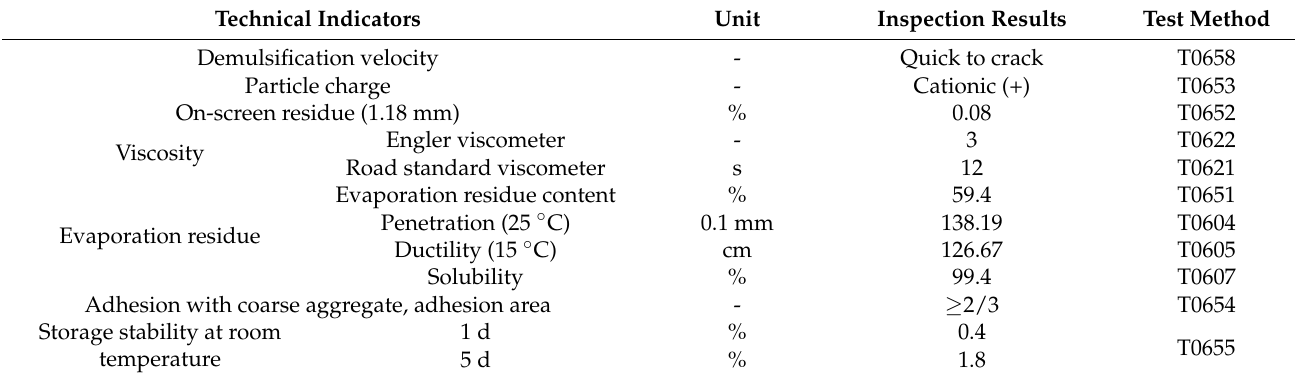
Table 3. Test results of emulsified asphalt A raw material.